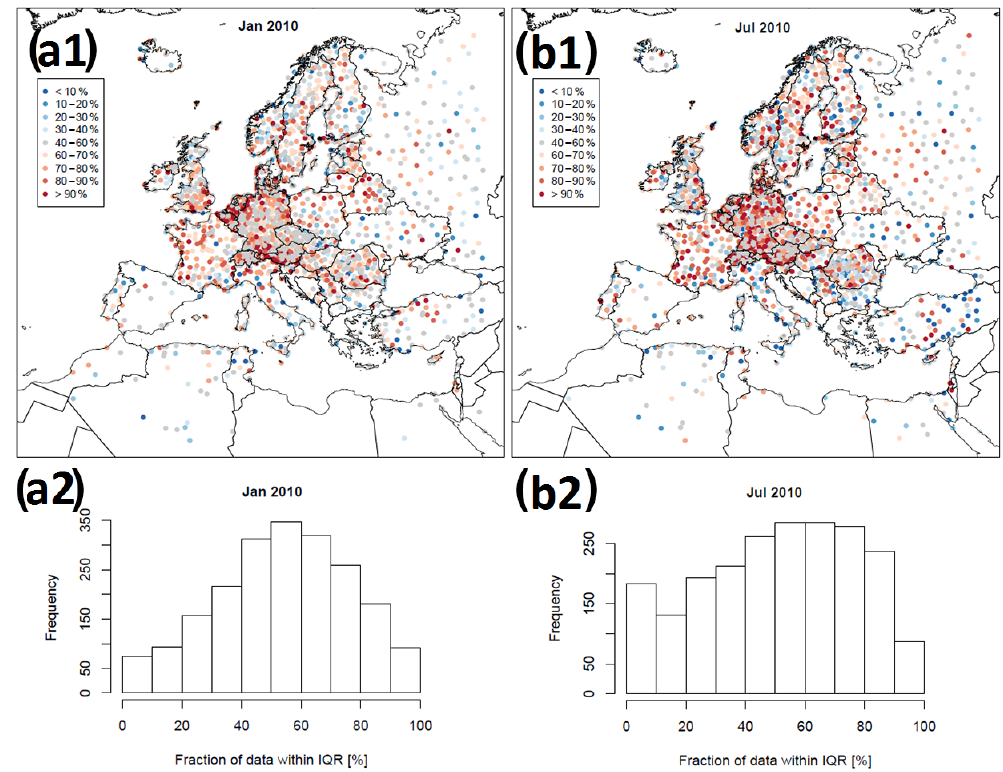
Figure 23. Comparison of cross-validation results with gridded uncertainty estimates for daily mean wind speed in January 2010 (a1) and July 2010 (b1) : fraction of interpolated daily data at stations within nearest-neighbor gridded IQR (interquartile range). Blue indicates an underestimation; red indicates an overestimation of the uncertainty. In panels (a2) and (b2) corresponding frequency distributions are